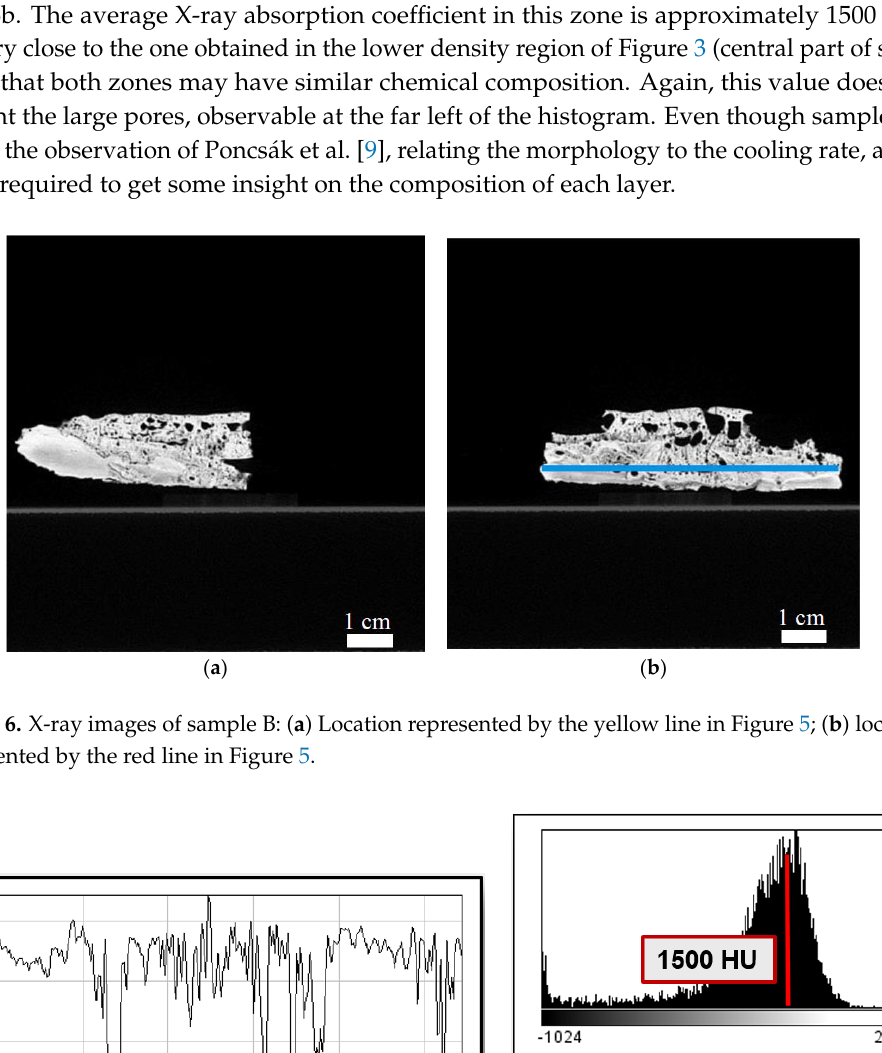
Figure 7. X-ray absorption coefficient (HU) distribution ( a ) and histogram ( b ) at the middle height of Figure 6b (blue line).